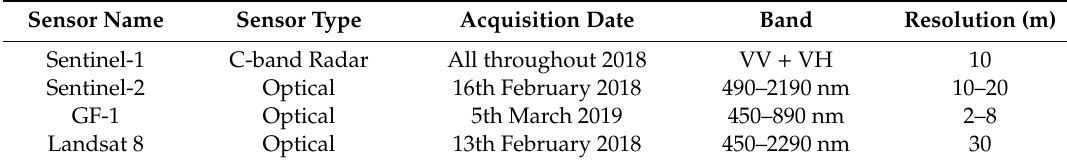
Table 1. Summary of the characteristics of the remotely sensed datasets used in the